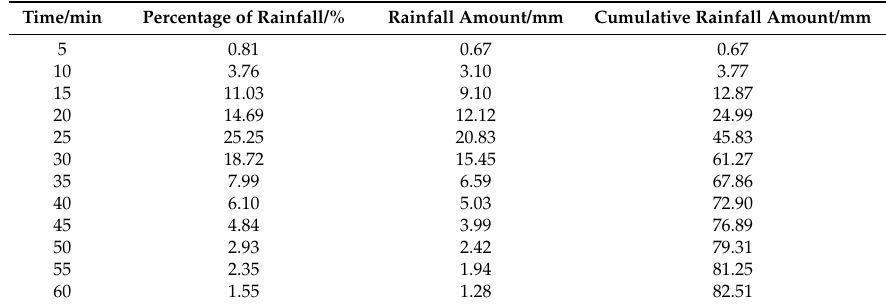
Table 3. Rainfall allocation of a single-peak rainstorm with a 60-min duration and a 20-year return period in Yangpu District.